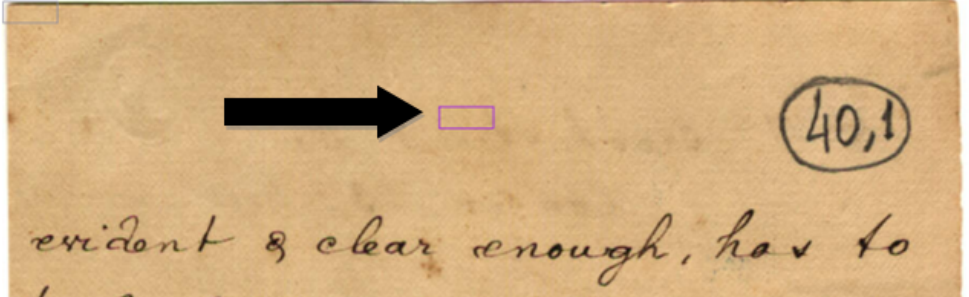
Figure 2. DIB—Choosing a texture pattern.